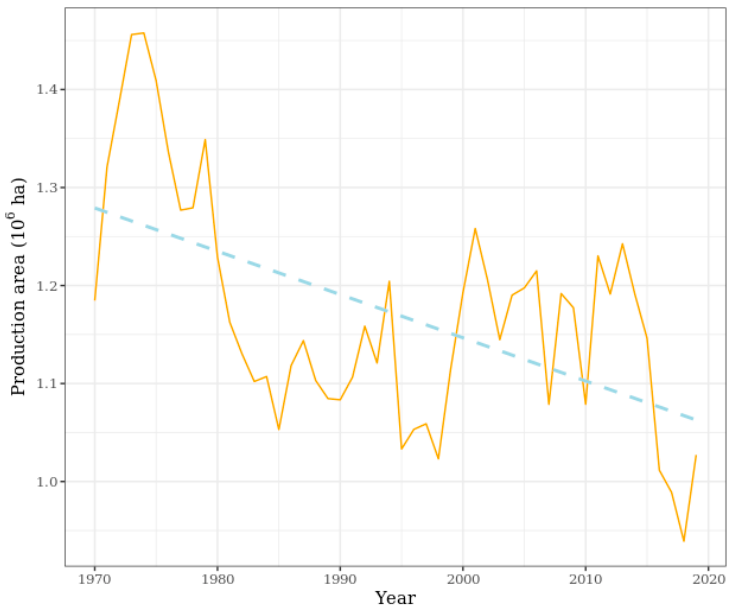
Figure 2. Changes in the maize production area in Hungary (1970–2019).